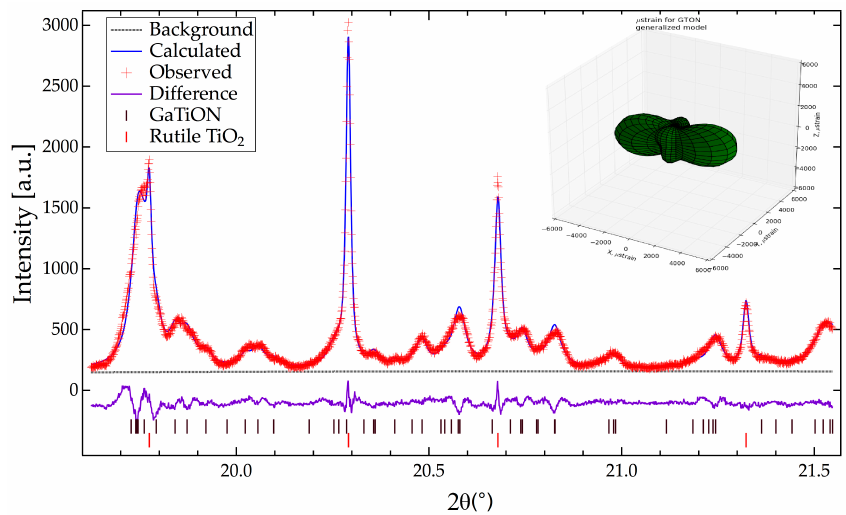
Figure 4. Rietveld fit to 11-BM (APS) X-ray profile containing an estimated TiO 2 (46 wt %) and the new phase related to V 2 GaO 5 (54 wt %). Note the much larger anisotropic strain, defined in GSAS-II [34] and originally introduced [35] and used by Stephens [36,37]. Note the sharper rutile peaks (vertical red markers) compared to those of the V 2 GaO 5 -related phase (vertical black